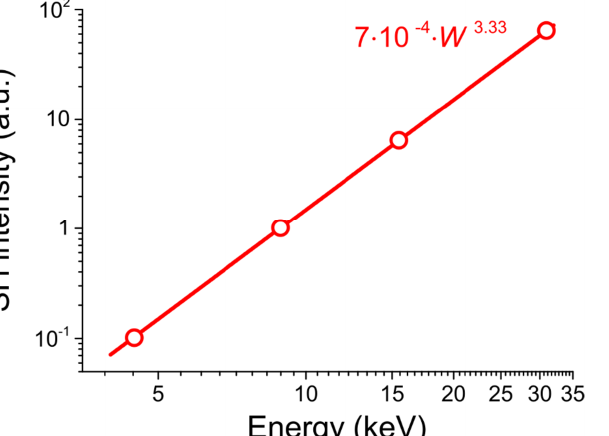
Figure 7. Based on CASINO modeling, calculated energy dependence (points) of the SH intensity in BF16 glass and its approximation (lines). Approximation of the results by a power function gave the SHG intensity in the form I SGH ~ d 2 ~ W 3.33 , and the exponent is 30% higher than the experimental one, I SHG ~ W 2.4 (see Figure